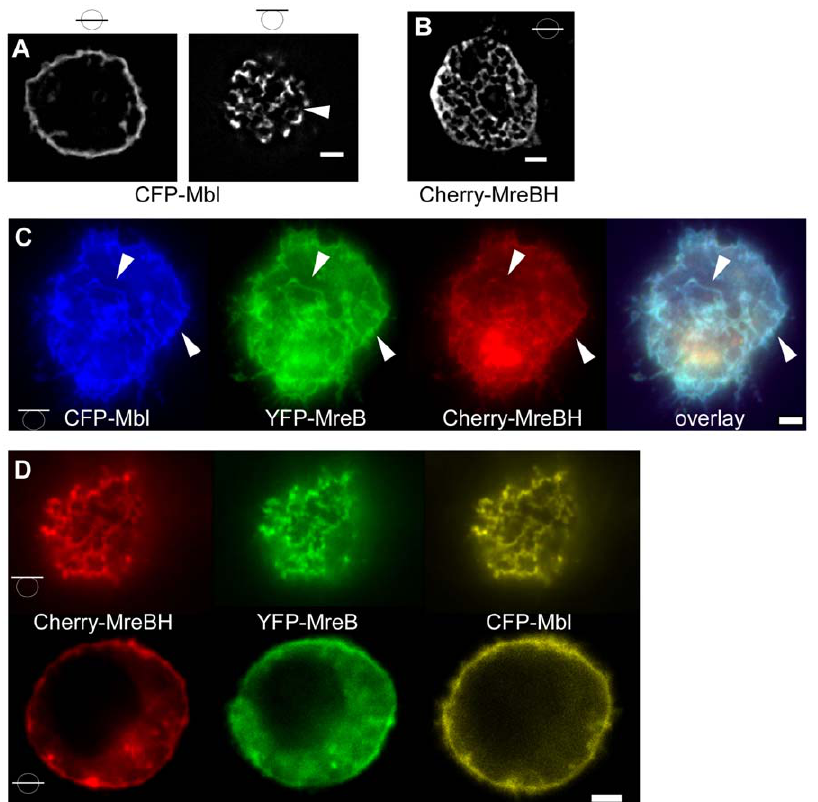
Figure 5. Expression of MreB paralogs in S2 cells. A) 3D deconvoluted images of CFP-Mbl, B) 3D deconvoluted image of mCherry-MreBH (middle plane). Bars in circles indicate position of image planes. C) Top view of a cell expressing YFP-MreB, CFP-Mbl and mCherry-MreBH, triangles indicate identical structures. D) Top and middle plane of a cell expressing all three MreB paralogs. White bars 2 m m.